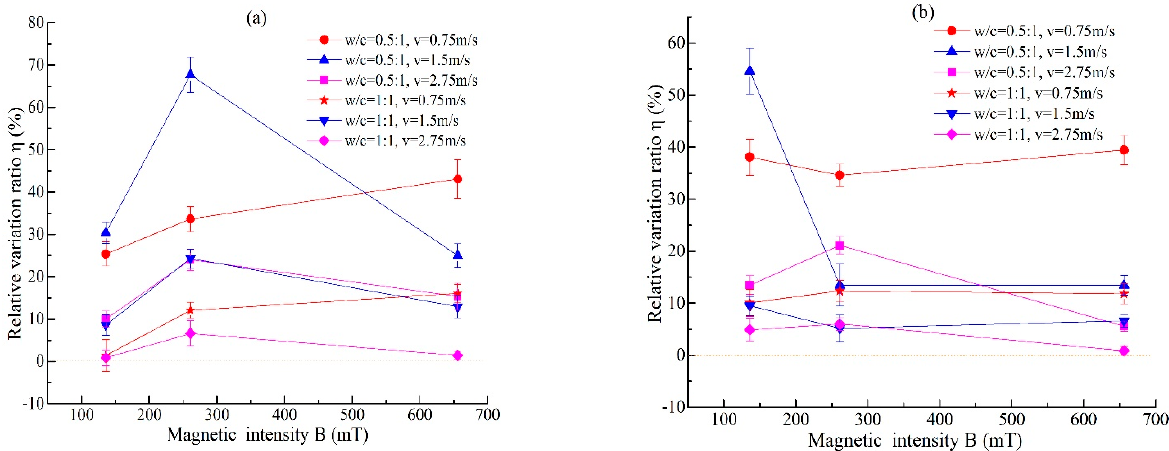
Figure 12. The values of η change with magnetic intensity under different magnetization conditions (( a ) n = 5, ( b ) n = 10).